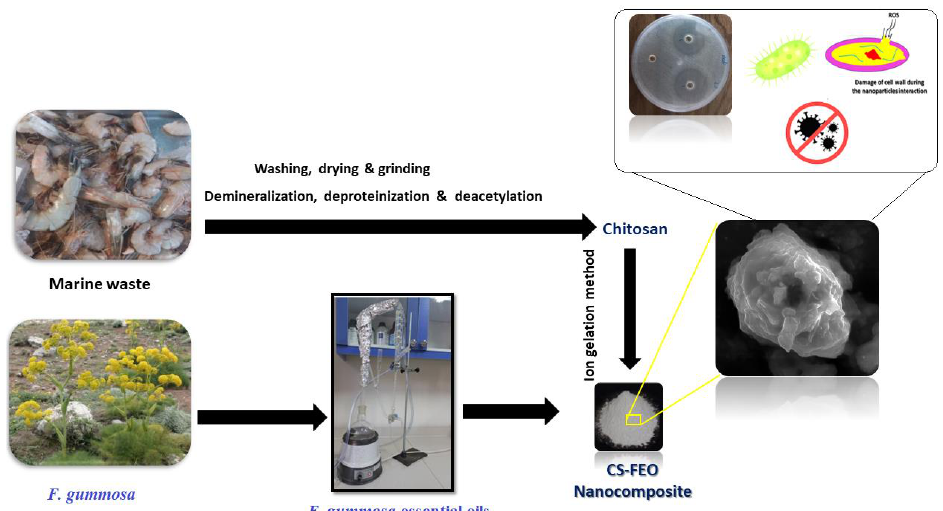
Fig. 1. A Brief schematic of the preparation method of the CS-FEO nanocomposite. Fig.1 A Brief schematic of the preparation method of the CS-FEO nanocomposite the preparation of